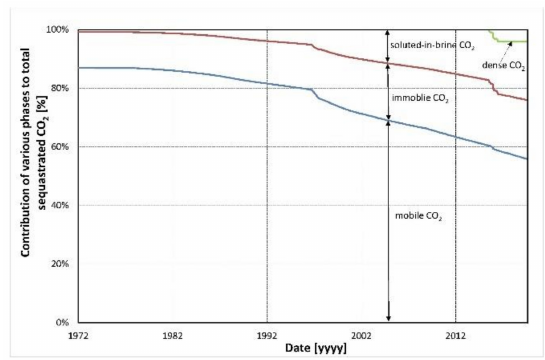
Figure 27. Contribution of various phases to total CO 2 in reservoir.